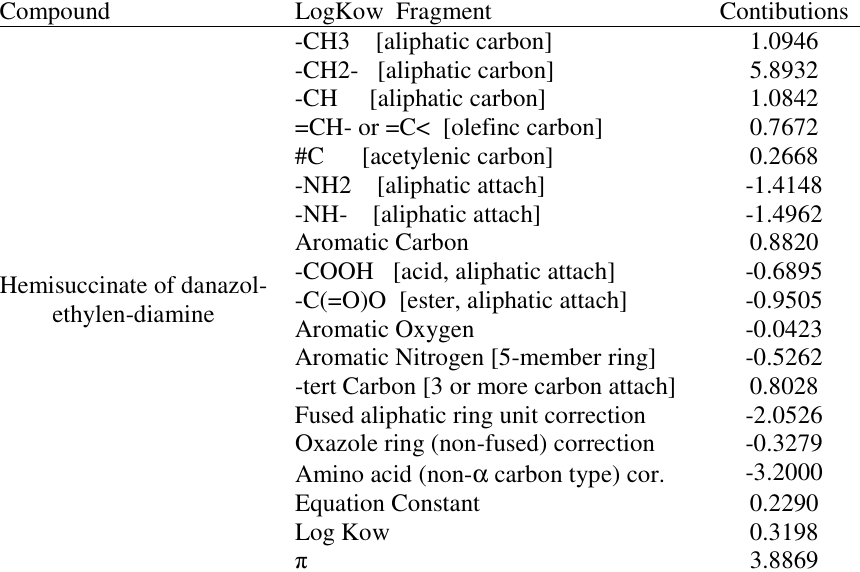
Table 1. Physicochemical parameters LogKow and π of hemisuccinate of danazol- ethylendiamine ( 3 )